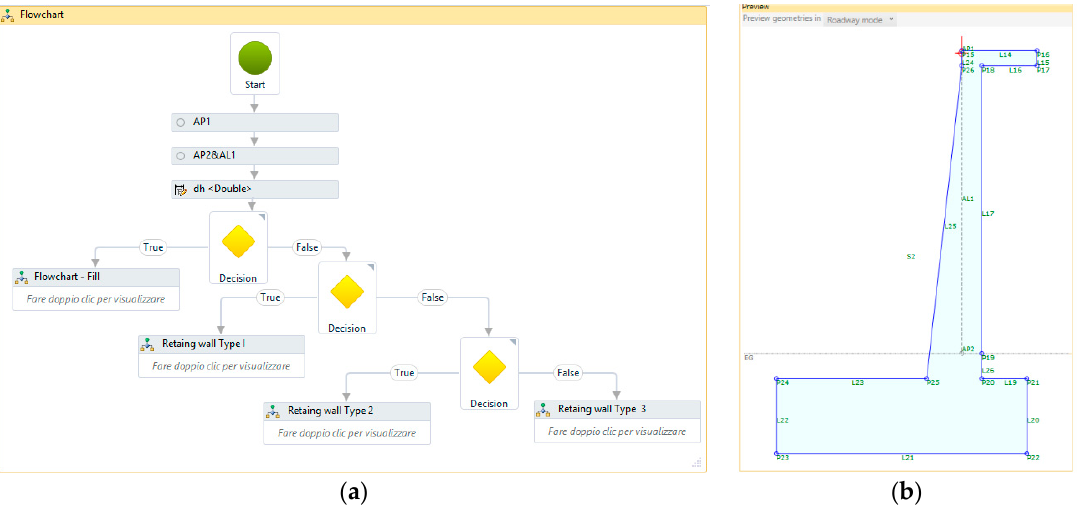
Figure 12. Modeling retaining walls using Subassembly Composer: ( a ) workflow; ( b ) result.